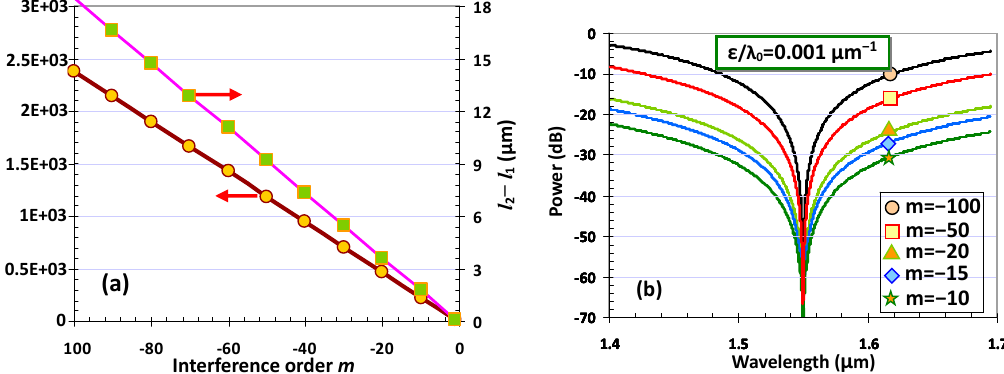
Figure 3. ( a ) The MZI arm length l 2 and the length difference ( l 2 − l 1 ) when choosing different interference order m ; ( b ) the calculated spectral responses of the MZI with different interference order m .